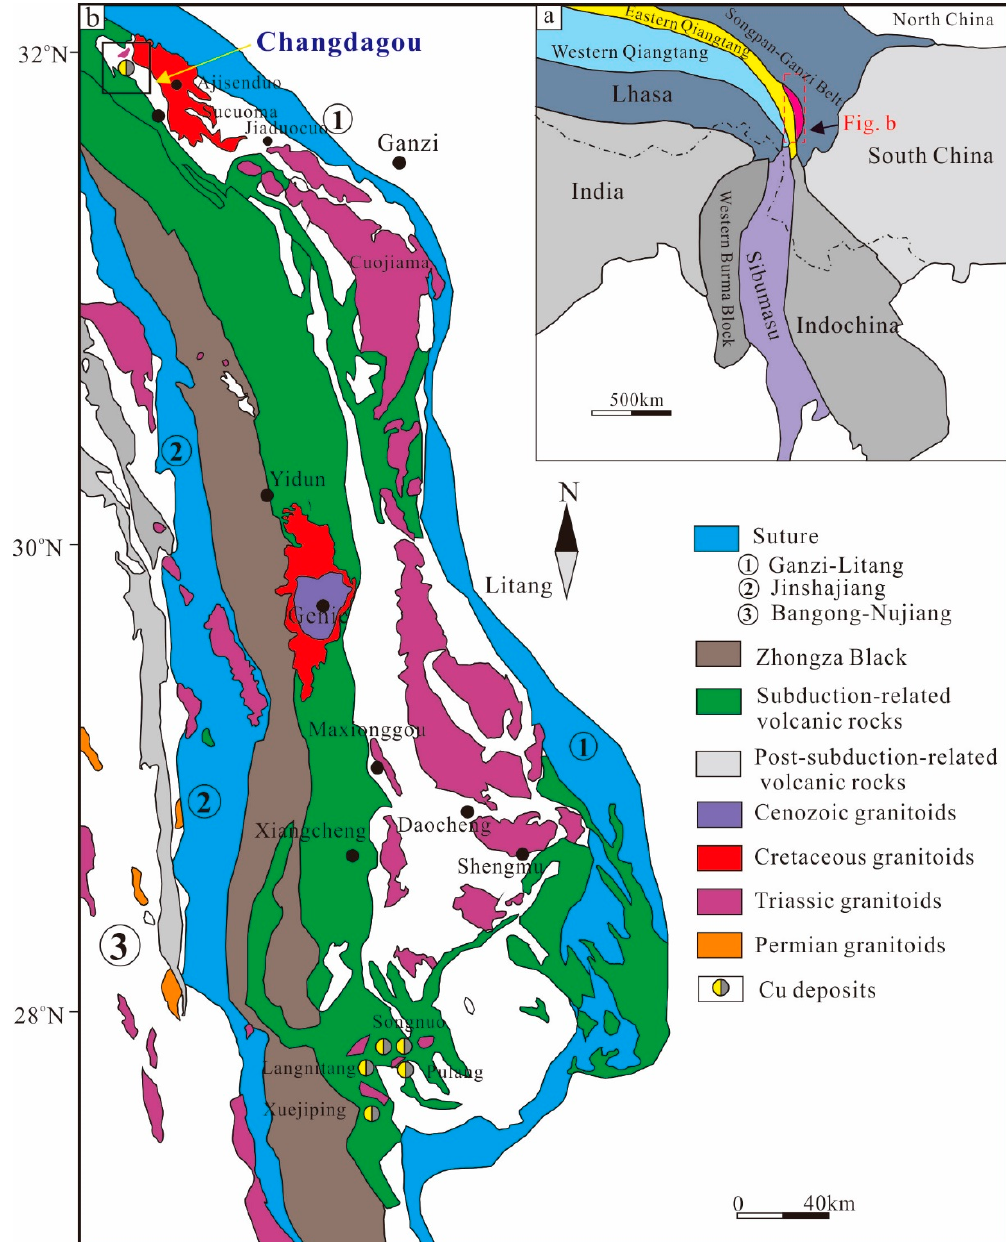
Figure 1. ( a ) Tectonic framework and distribution of major geological terranes and sutures of mainland SE Asia; ( b ) Tectonic framework of the Sanjiang Region, including the major geological terranes, sutures, volcanic rocks and intrusions (modified after [6]).